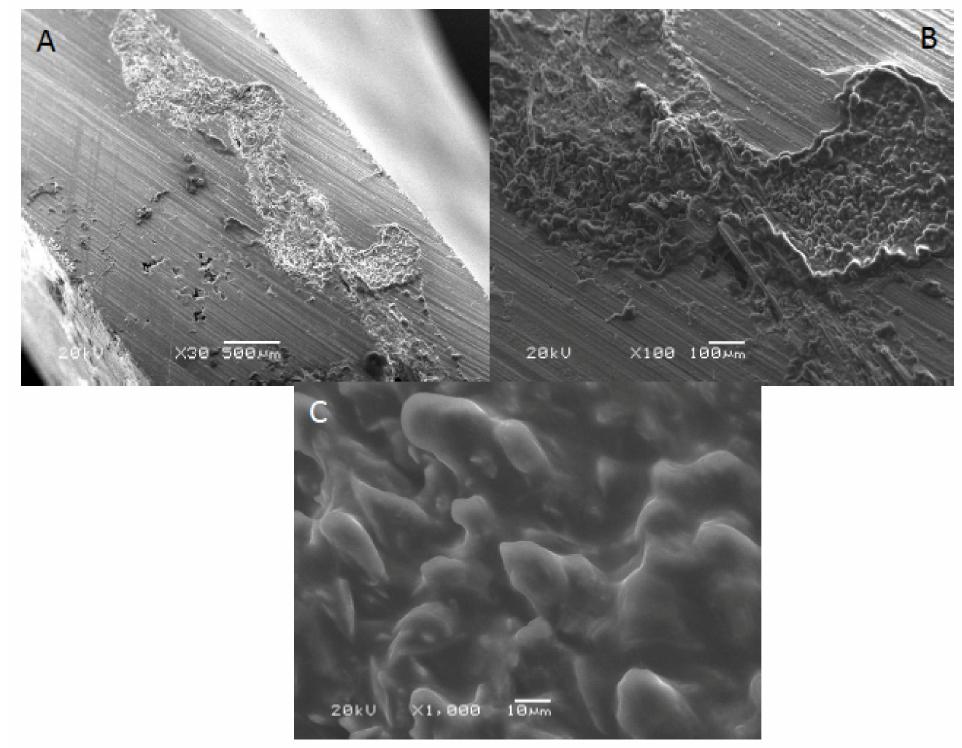
Figure 4. SEM images of acrylic denture reinforced with dental fiberglass framework (group 1) at ( A ) × 30, ( B ) × 100 and ( C ) × 1000